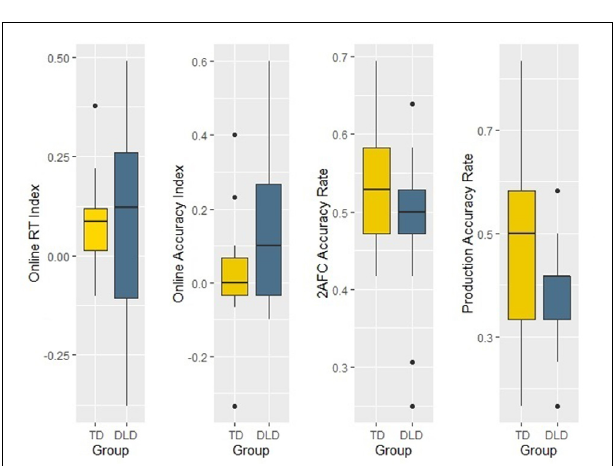
FIGURE 5 | Learning indices of the two groups in the acoustic verbal segmentation task.